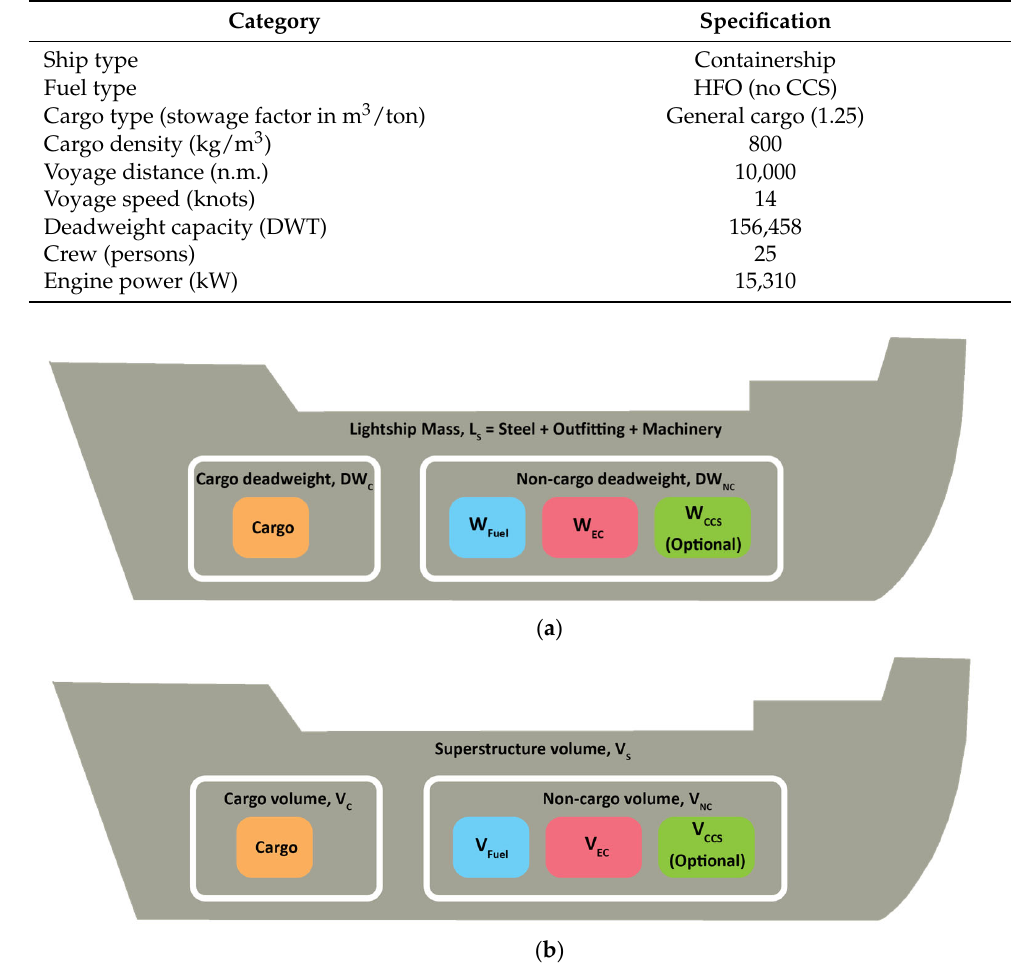
Figure 2. ( a ) Weight and ( b ) volume distributions of a ship.